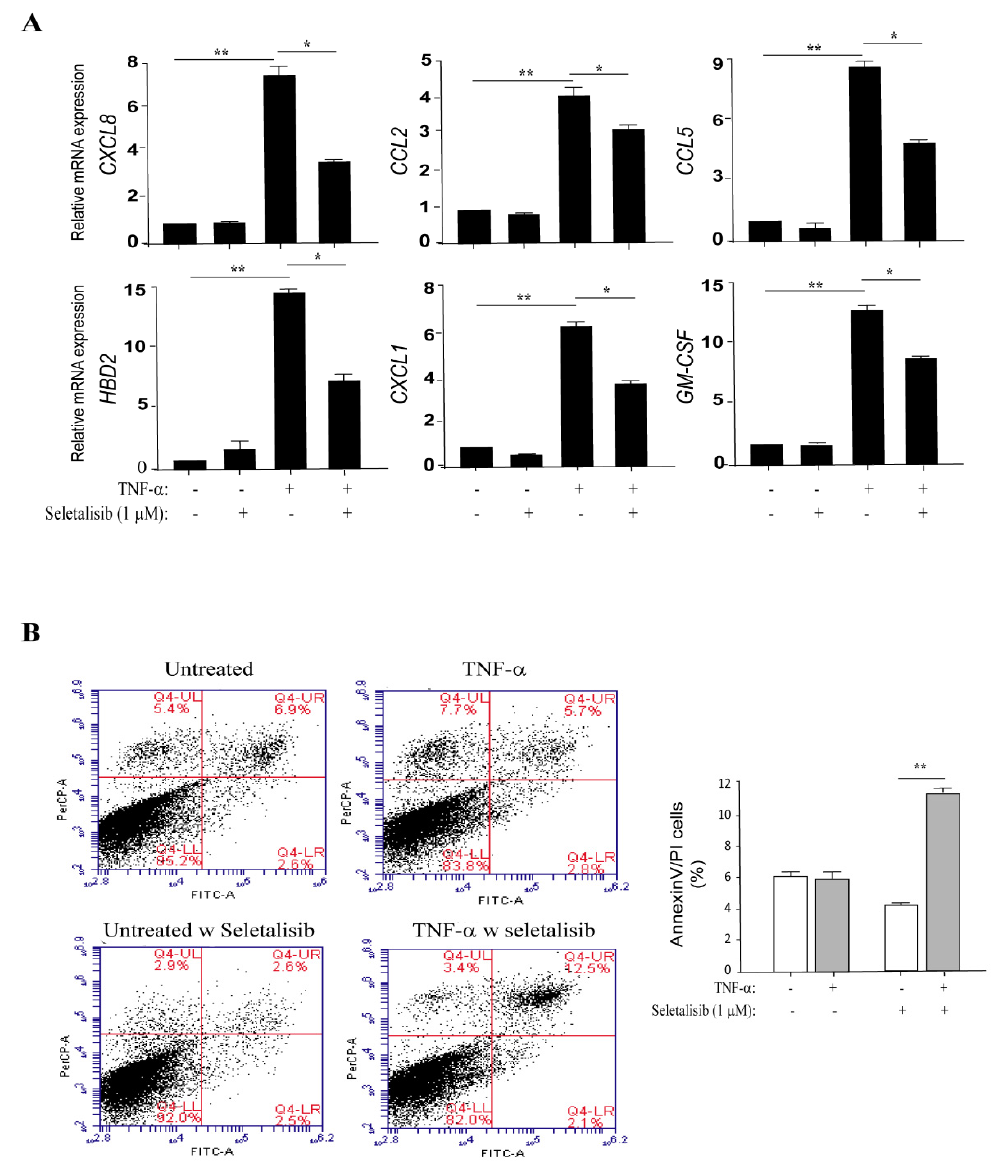
Figure 4. PI3K δ inhibition reduces the expression of inflammatory genes and induces apoptosis in TNF- α -activated psoriatic keratinocytes. ( A ) Keratinocyte cultures were left untreated or stimulated with TNF- α in presence or absence of seletalisib (1 µ M) for 8 h, and CXCL8 , CCL2 , CCL5 , HBD-2 , CXCL1 , and GM-CSF mRNA expression was detected by real-time PCR and normalized to HPRT1 levels. Data shown are the mean of three different experiments ± SD. * p ≤ 0.05, ** p ≤ 0.01, as assessed by paired Student’s t test. ( B ) Psoriatic keratinocytes were pre-treated or not with seletalisb (1 µ M) and then stimulated with TNF- α for 48 h. Apoptosis was evaluated by measuring Annexin/PI fluorescent staining through FACS analysis. Graphs show the mean ± SD of the percentage of AnnV/PI double-positive cells of three independent experiments. ** p ≤ 0.01, as assessed by paired Student’s t test.